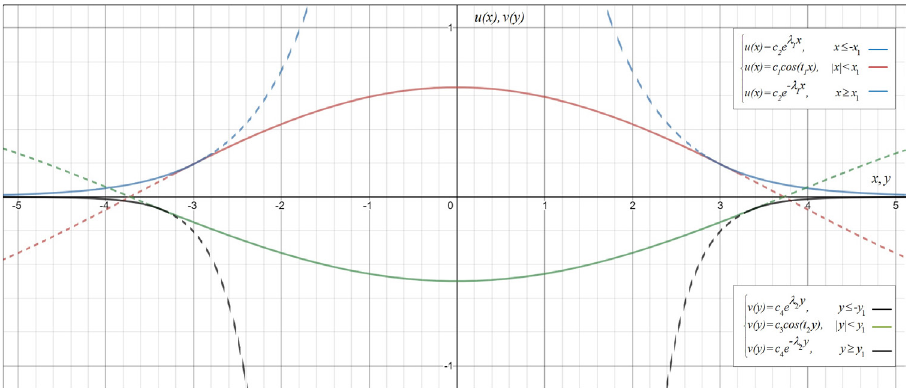
Figure 2. Graphical solution of system (2) for the values of parameters: α = β = γ = D 1 = D 2 = 1, σ = 2, σ = 8, x = 3, y = 3 . 3630, k = 0422 , c 1 2 1 1 906 . 7560. The function u ( x ) is described by the blue and red solid lines that smoothly continue each − other at the point x 1 . Similarly, the function v ( y ) is composed by solid black and green